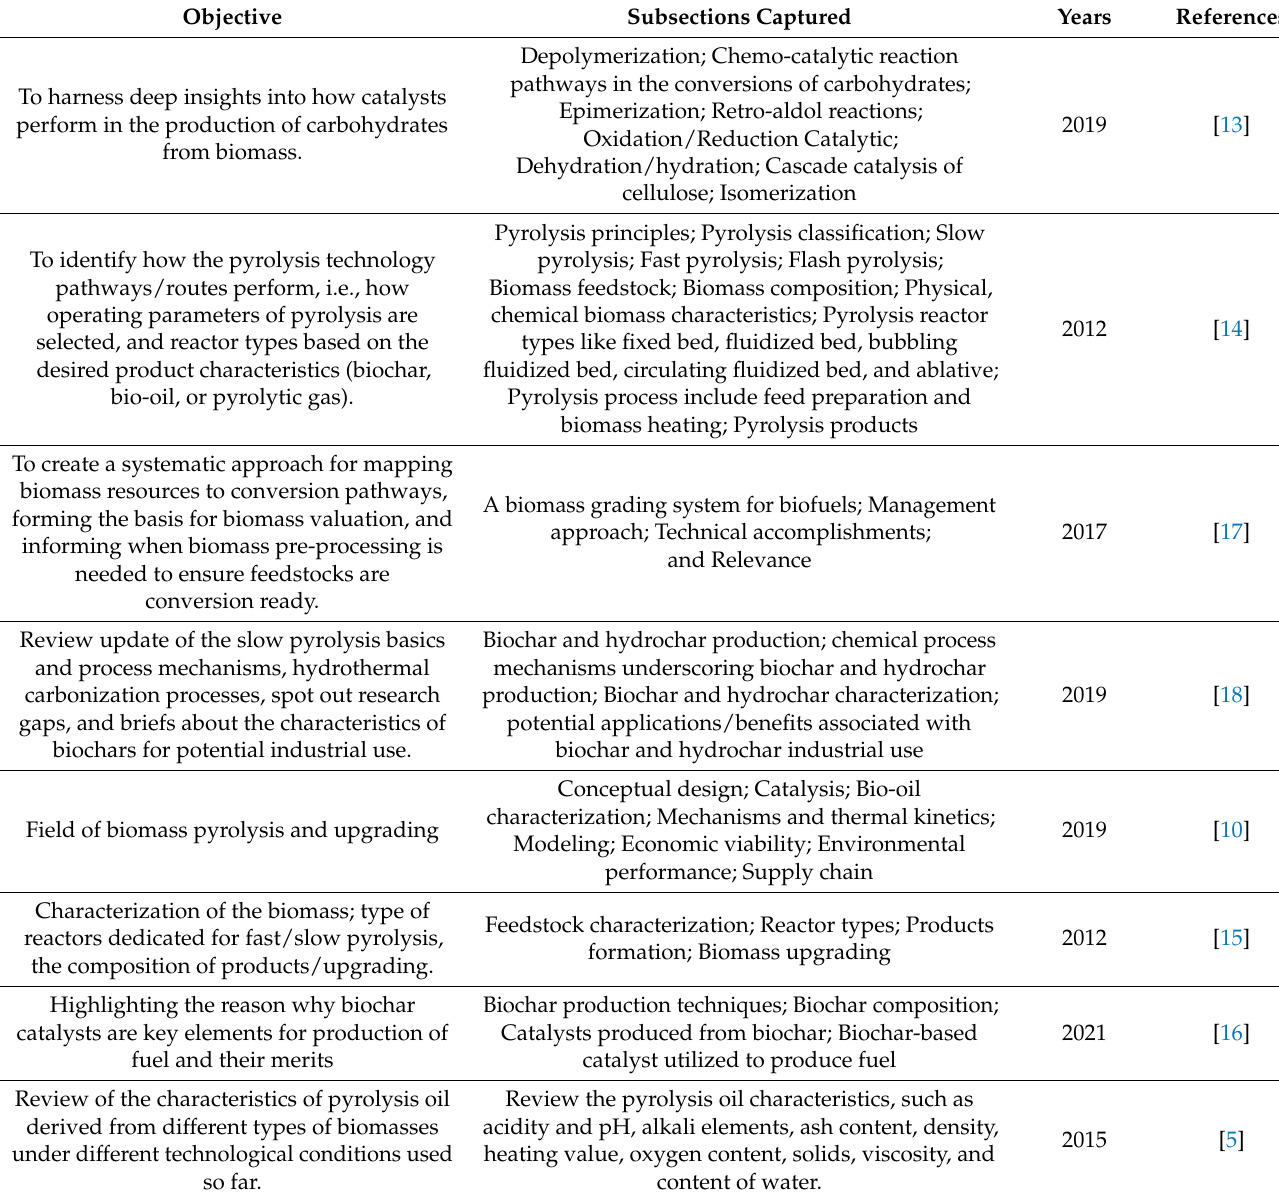
Table 1. Previously conducted reviews involving pyrolysis on different biomasses and different conditions/situations, with their respective objectives and subsections